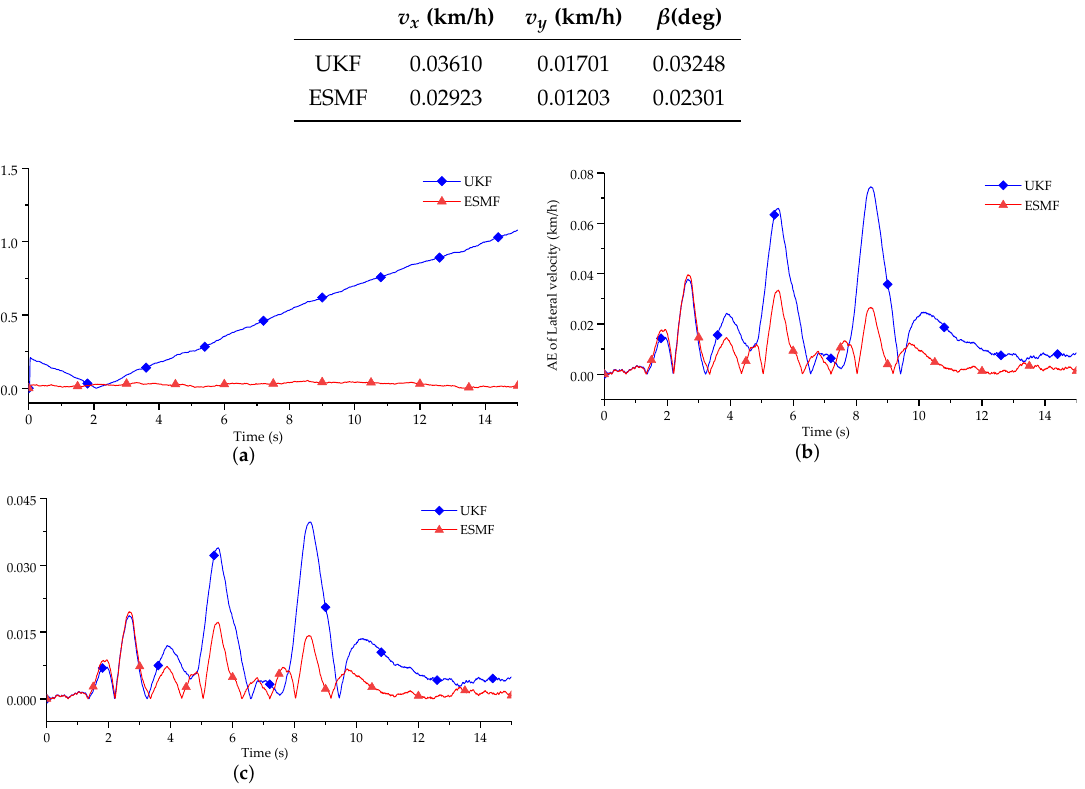
Figure 13. AE curves of two strategies under the DLC maneuver. ( a ) Longitudinal velocity; ( b ) Lateral velocity; ( c ) Vehicle sideslip angle.